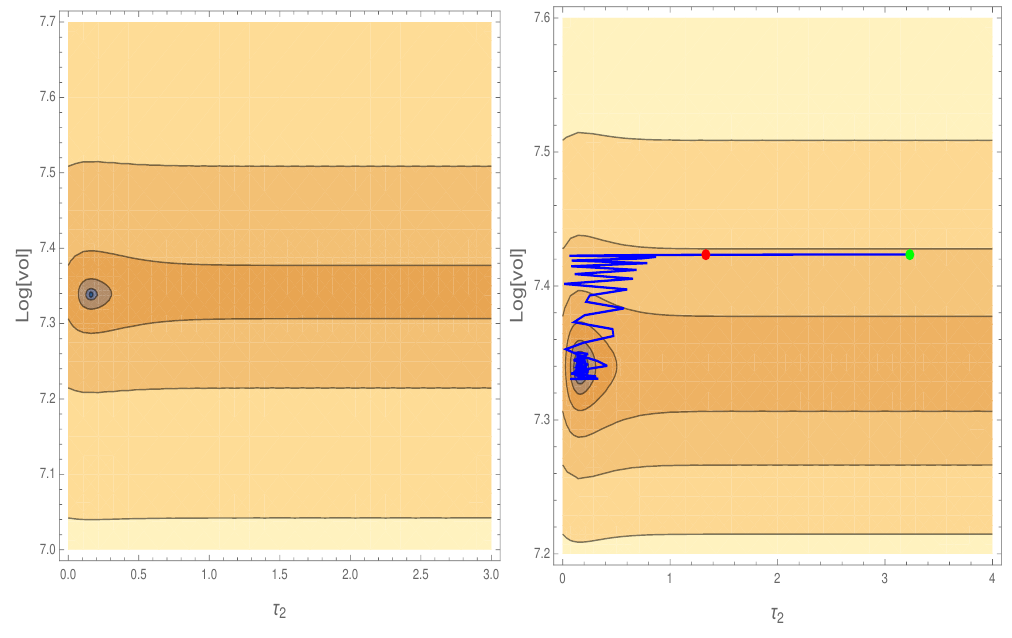
Figure 8 . In(cid:13)ationary trajectory in the ( (cid:28) 2 , ln green dot represents horizon exit while the red dot denotes the end of slow-roll in(cid:13)ation where (cid:15) s = 1.